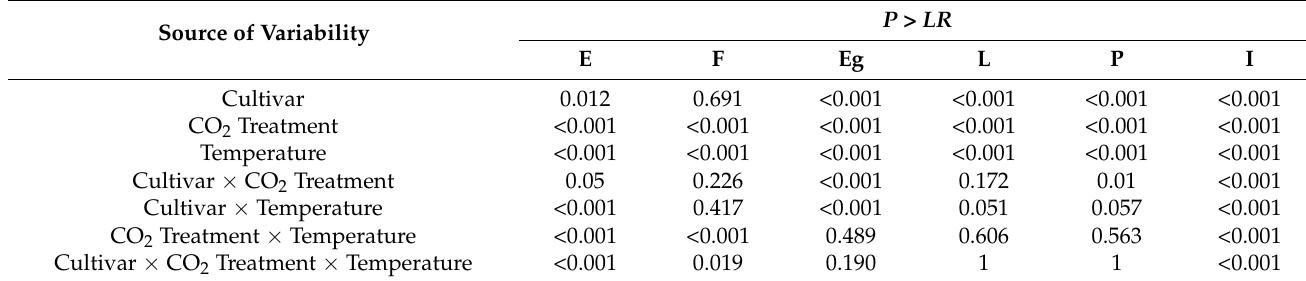
Table 1. Analysis of variance for several measurements on the